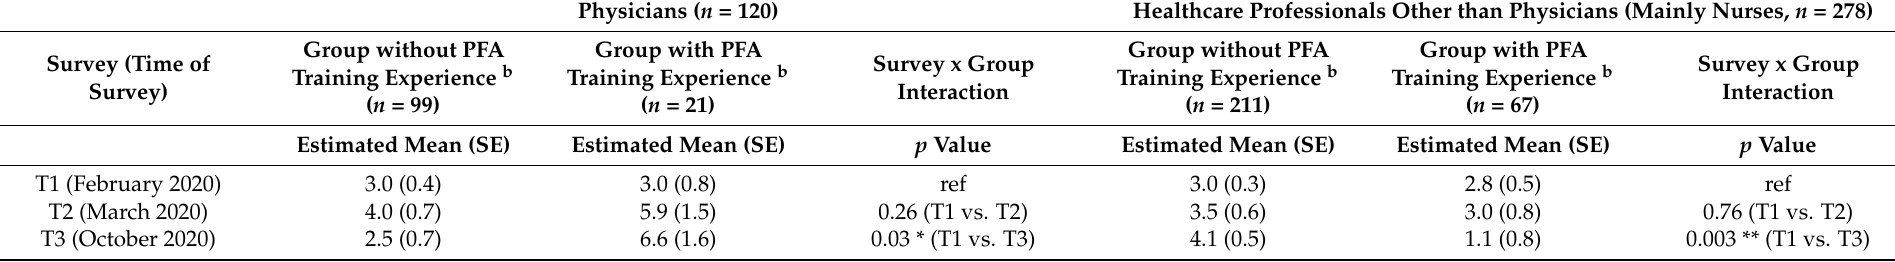
Table 2. The crude estimated mean of psychological distress a at baseline (T1), T2, and T3 during the COVID-19 pandemic among a cohort of Japanese healthcare professionals: the mixed model with repeated measures (N = 398).